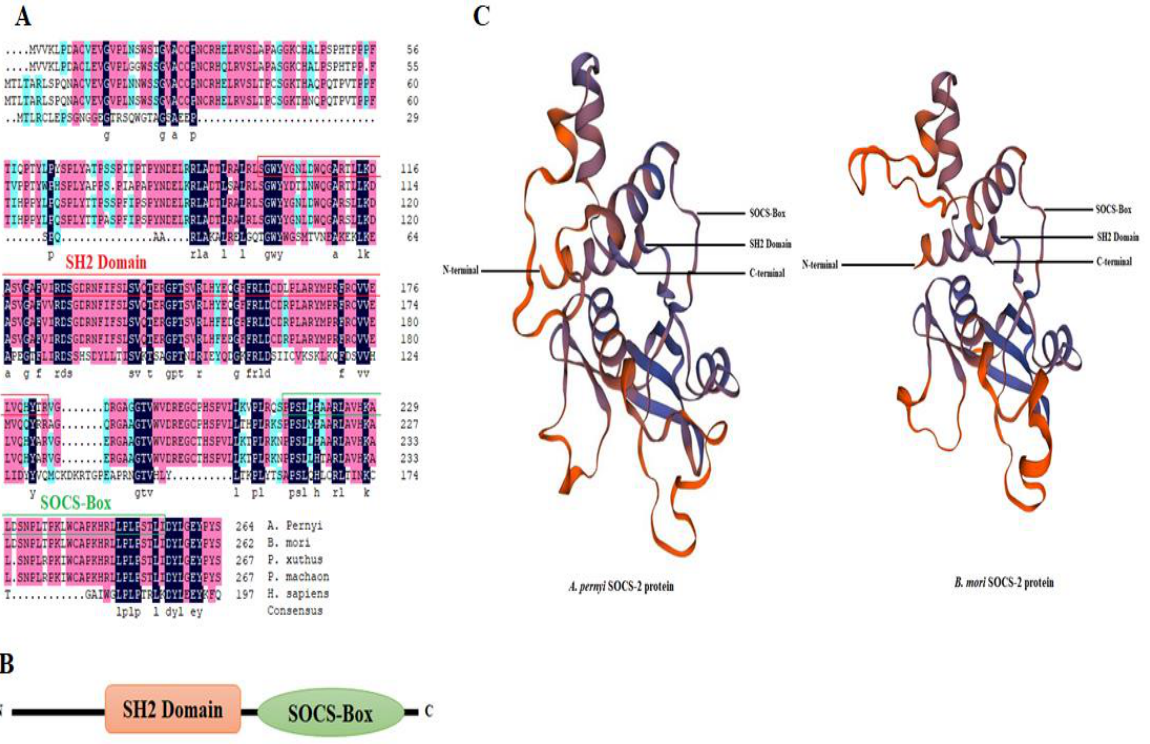
Figure 1. Multiple sequence alignment and tertiary structure of ApSOCS-2 protein. ( A ) Sequence alignment of ApSOCS-2 protein with those of other SOCS/CIS family proteins from Bombyx mori (NM_001256992.1), Papilio xuthus (KPJ02665), Papilio machaon (KPJ08265), and Homo sapiens (NP_001257396). The conserved domains are represented by red and green boxes in the sequence alignment. ( B ) Conserved domains of ApSOCS-2 protein: SH2 Domain and SOCS-Box of Antheraea pernyi. ( C ) The prediction of SOCS-2 protein tertiary structure of A. pernyi using SWISS-MODEL program. The SH2, SOCS-box domains, N and C terminals in the protein structures are labeled.